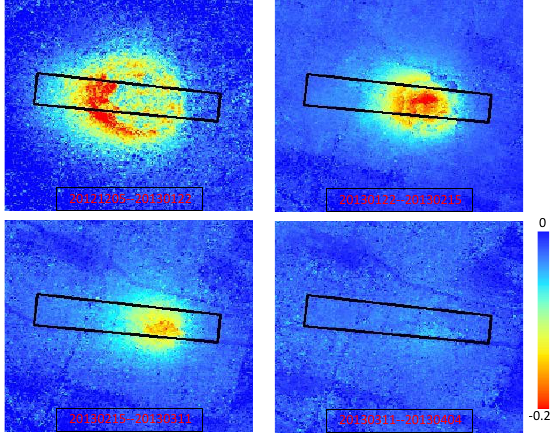
Figure 6. The ground deformation of four interferometric pairs (Unit: m)